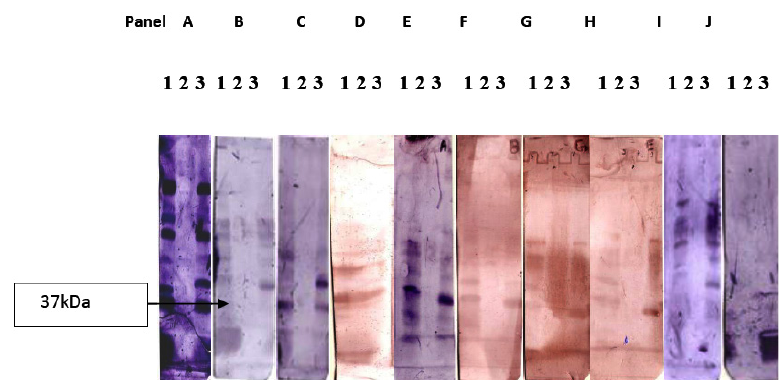
Fig. 3. 10panels, 3 lanes each, as follows:Lane 1: S.typhi cells-15 µl.Lane 2: LPS (Sigma)-15 µg Lane 3: Control cells of another gram negative bacteria-15 µl. Panel A –Positive control sera.Panel B –Negative control sera.Panel C – Patients sample (positive).Panel D - Patients sample (positive).Panel E - Patients sample (positive) Panel F – Patients sample (positive).Panel G – Patients sample (negative).Panel H - Patients sample (negative).Panel I - Patients sample (negative).Panel J - Patients sample